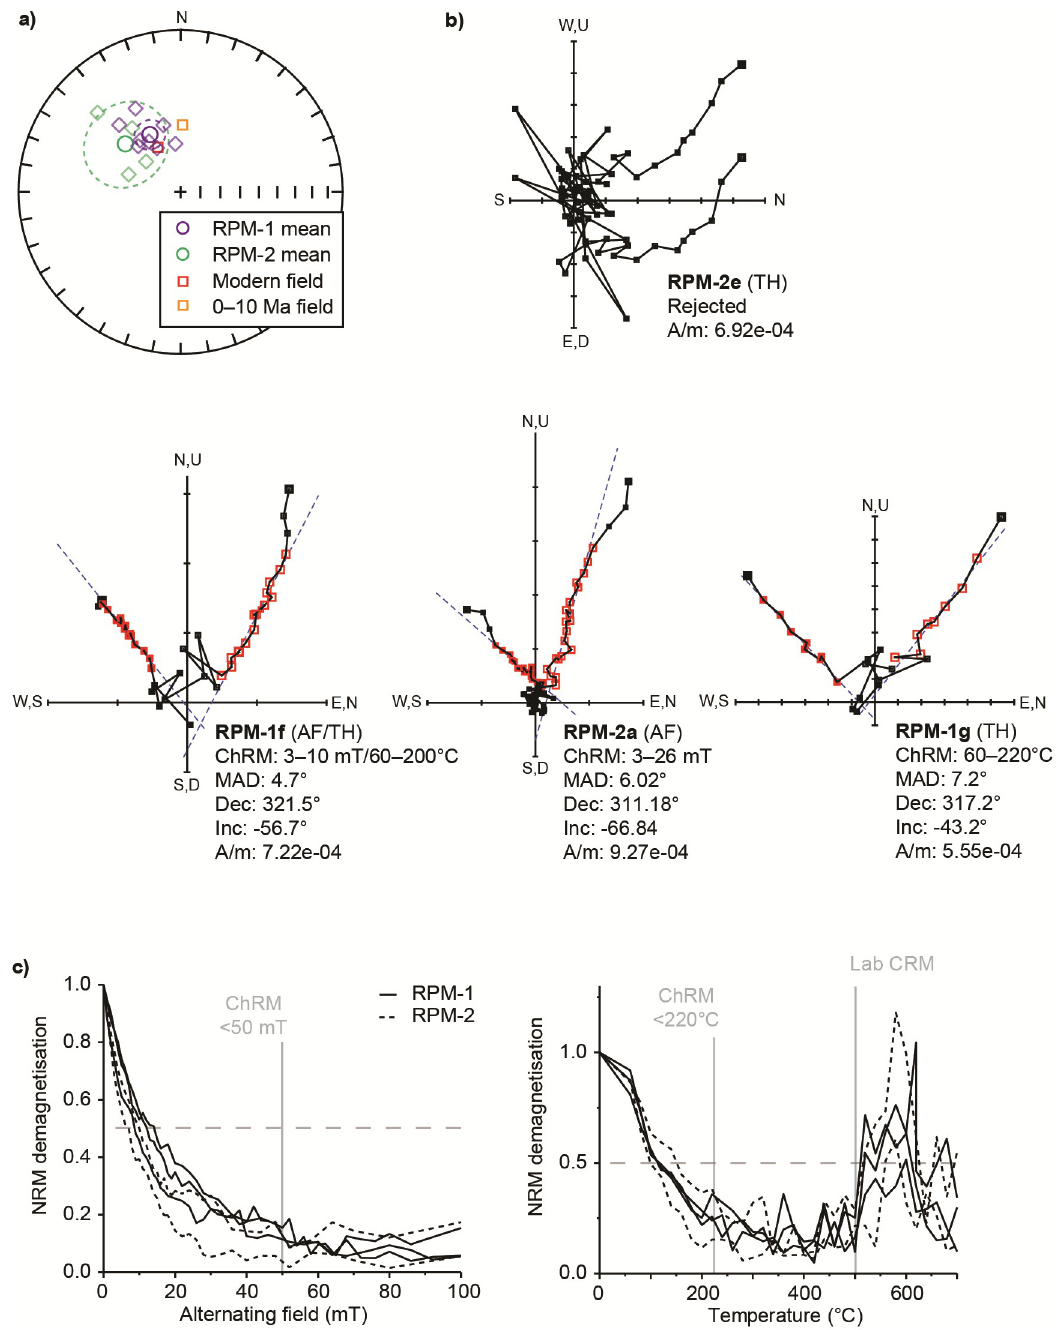
Fig 5. Palaeomagnetic data for Amanzi Springs Area 1. A) Stereographic projection showing Fisher (1953) mean directions for RPM-1 and RPM-2 and α 95 confidence ellipses (dotted circles) with their respective subsamples (diamonds). Open symbols indicate a negative inclination. These are plotted against directions for the modern geomagnetic field at Amanzi Springs, and estimates for the time averaged dipole field here over 0–10 Ma. The latter was derived from an average of 0 Ma and 10 Ma reference data in [126] for the African Plate Apparent Polar Wander Path for Amanzi Springs in Paleomagnetism.org [127]. B) Representative vector AF, TH and AF/TH demagnetisation diagrams. Note that erratic data points have been removed in RPM-1g ( > 340˚C) and RPM-1f ( > 280˚C) for clarity, see rejected subsample RPM-2e for an example of this behaviour. C) AF (left) and TH (right) demagnetisation spectra (note that AF/TH spectra are not shown).